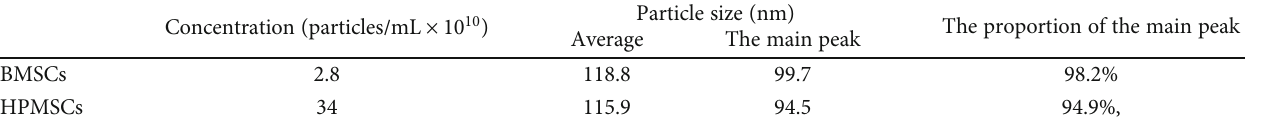
Table 1: Exosomes characterized by NTA.